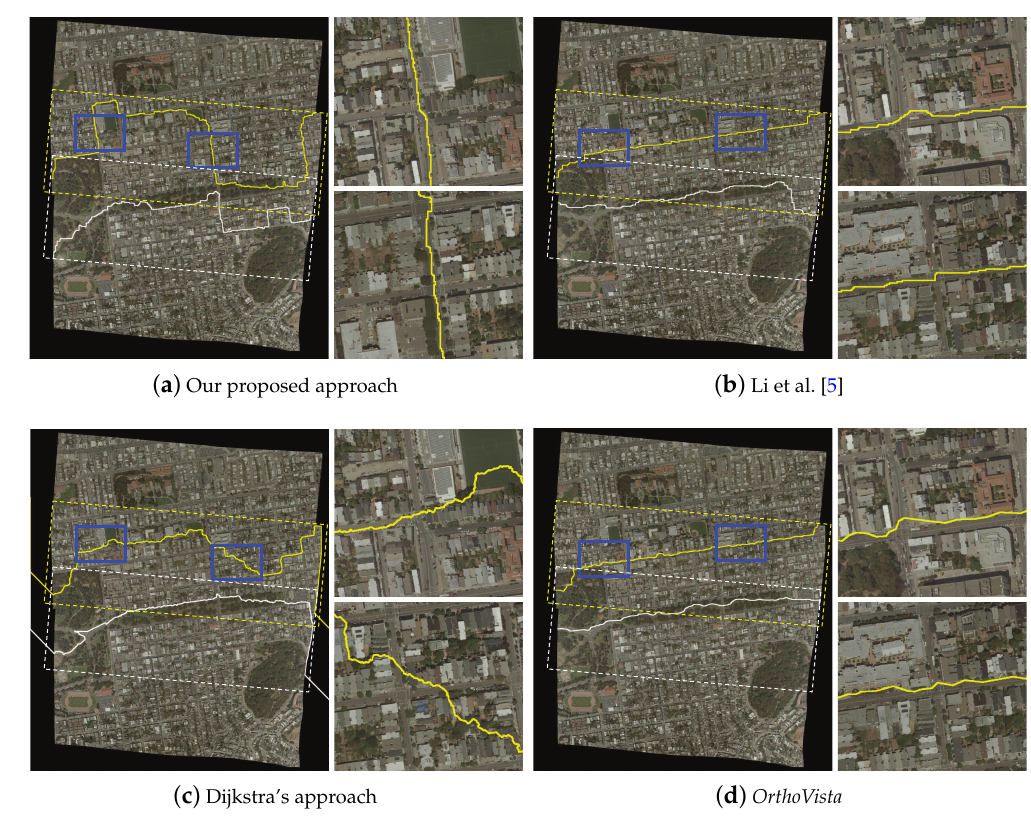
Figure 12. The seamlines detected by our proposed approach ( a ), Li et al. [5] ( b ), Dijkstra’s approach ( c ) and OrthoVista ( d ) on the first group of images. The dash boxes represent the overlapped regions between input images.